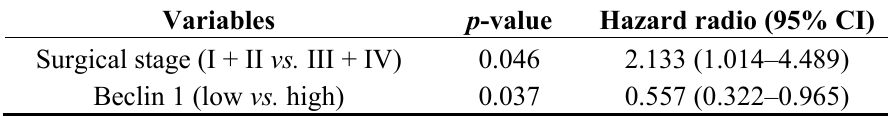
Table 3. Multivariate analysis of the prognosis of patients with ovarian